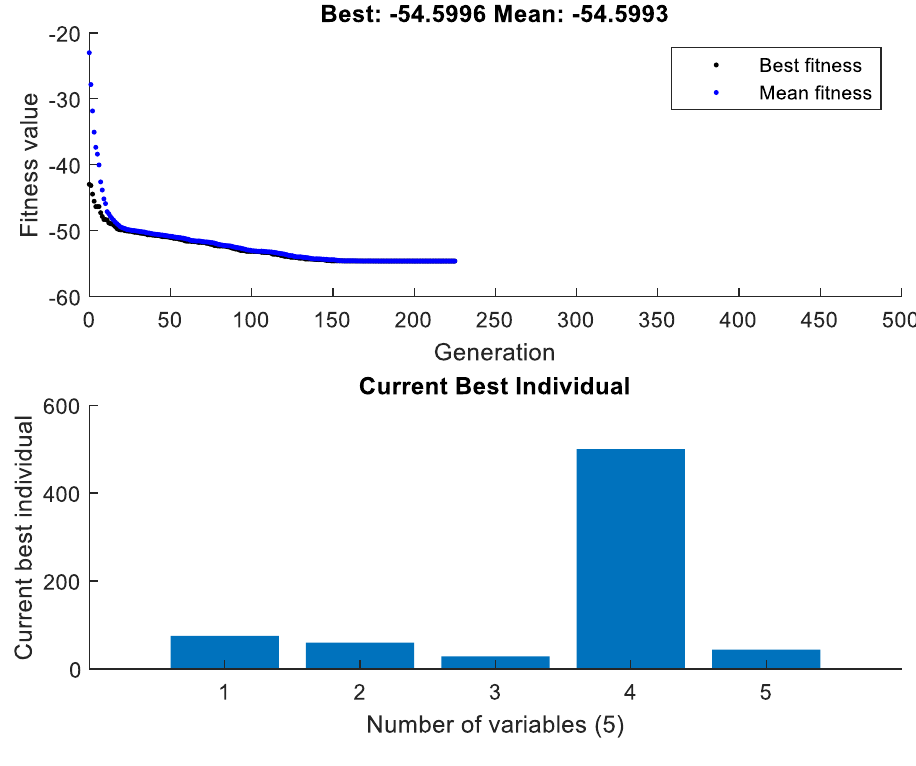
Figure 9. Current best individual using GA.